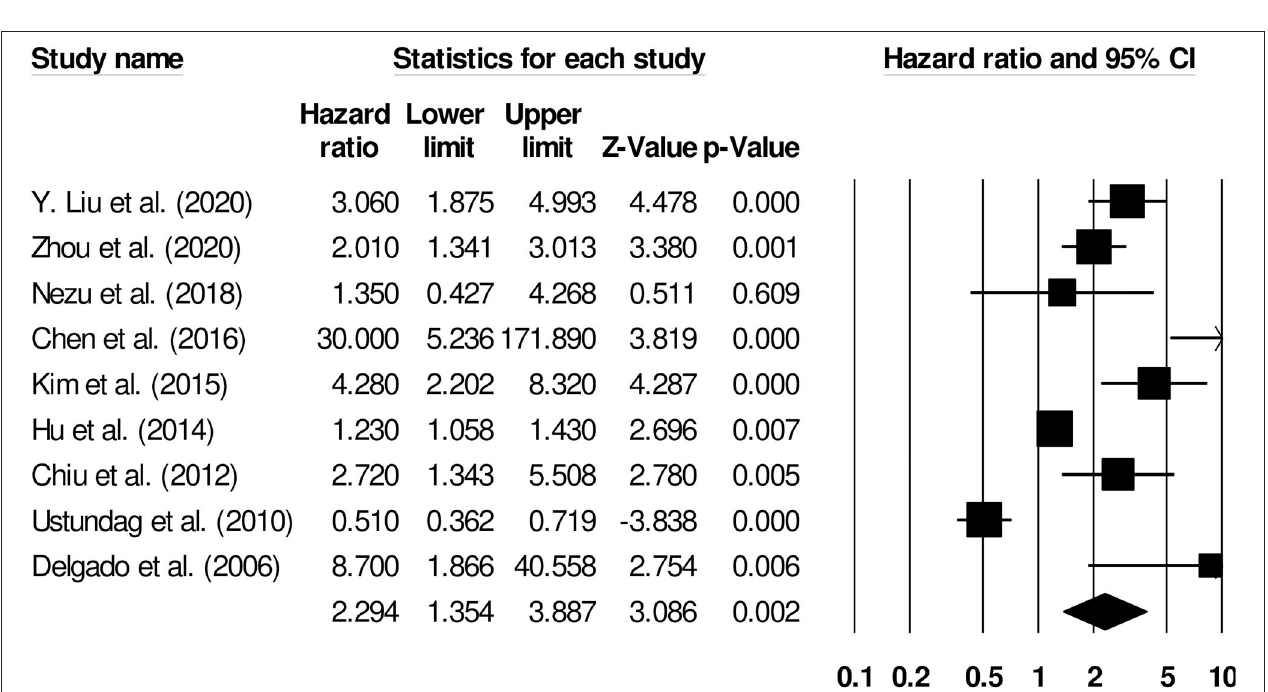
FIGURE 8 | Forest plot for studies evaluating the impact of D-dimer level on post-intracerebral hemorrhage functional outcomes for 2 months follow up. Hazard ratios are presented as black boxes while 95% confidence intervals are presented as whiskers. A small hazard ratio represents a lower influence of D-dimer levels on stroke patient functional outcome while a higher hazard ratio represents a higher influence.